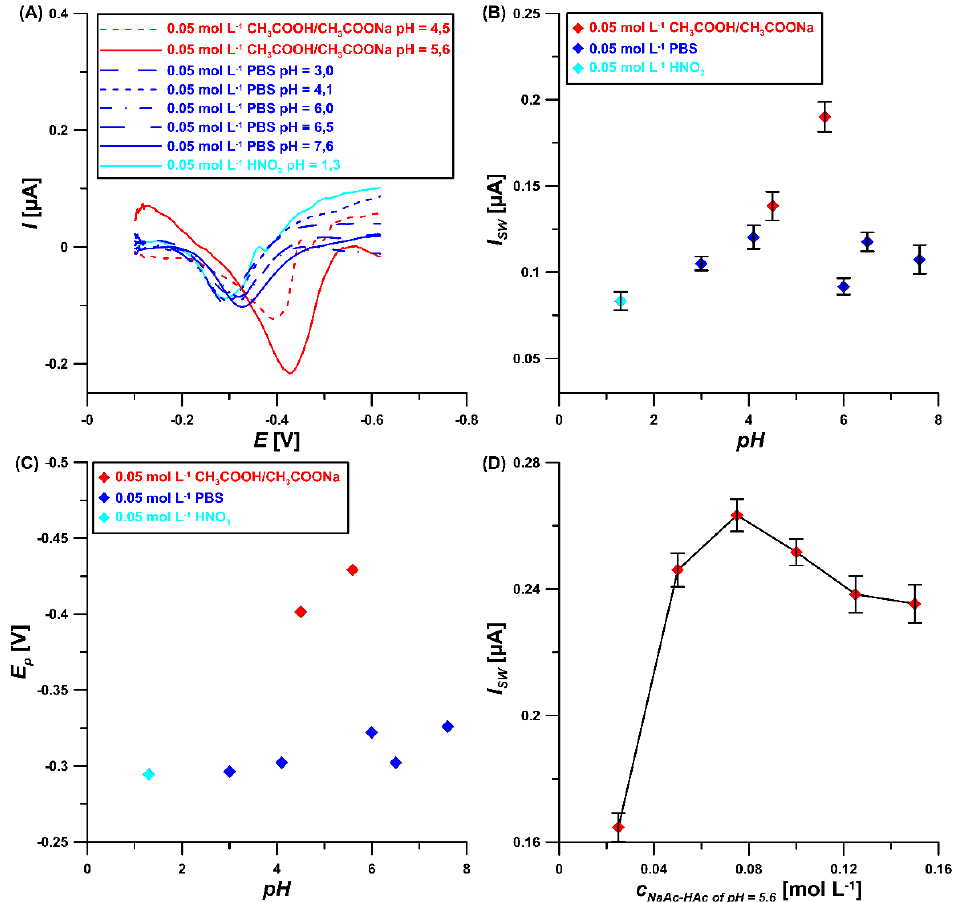
Figure 5 . ( A ) SWV curves in different supporting electrolytes. The relationship between: ( B ) I SW and pH, ( C ) E p and pH and ( D ) I SW and the concentration of NaAc – HAc buffer of pH = 5.6. The experiments were performed for 5 µM ROX and 40 mg/L CTAB. The standard deviation was calculated for n = 3.